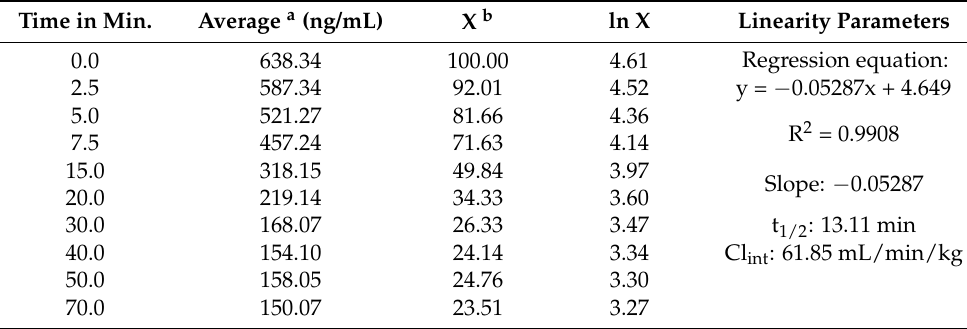
Figure 5. ( A ) The capmatinib (CMB) metabolic stability curve in HLMs; ( B ) linear part of the logarithm (ln) calibration curve, revealing the regression equation. Table 7. Metabolic stability of capmatinib (CMB). Time in